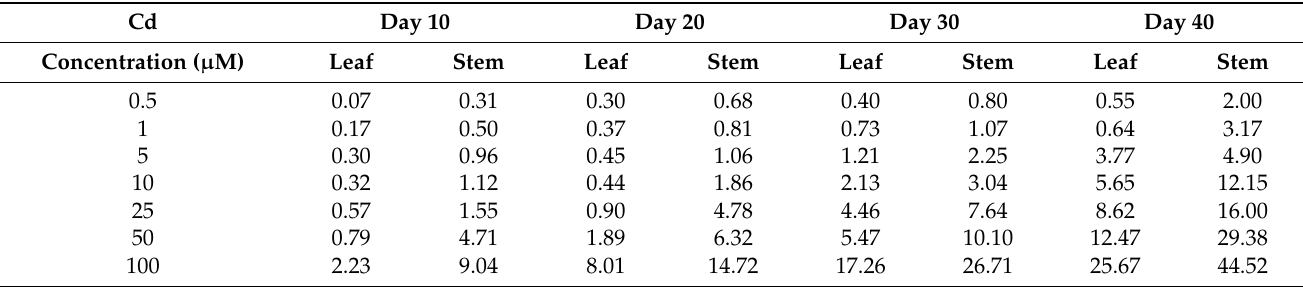
Table 1. Target hazard quotient (THQ) values of A. selengensis after 40 days of liquid